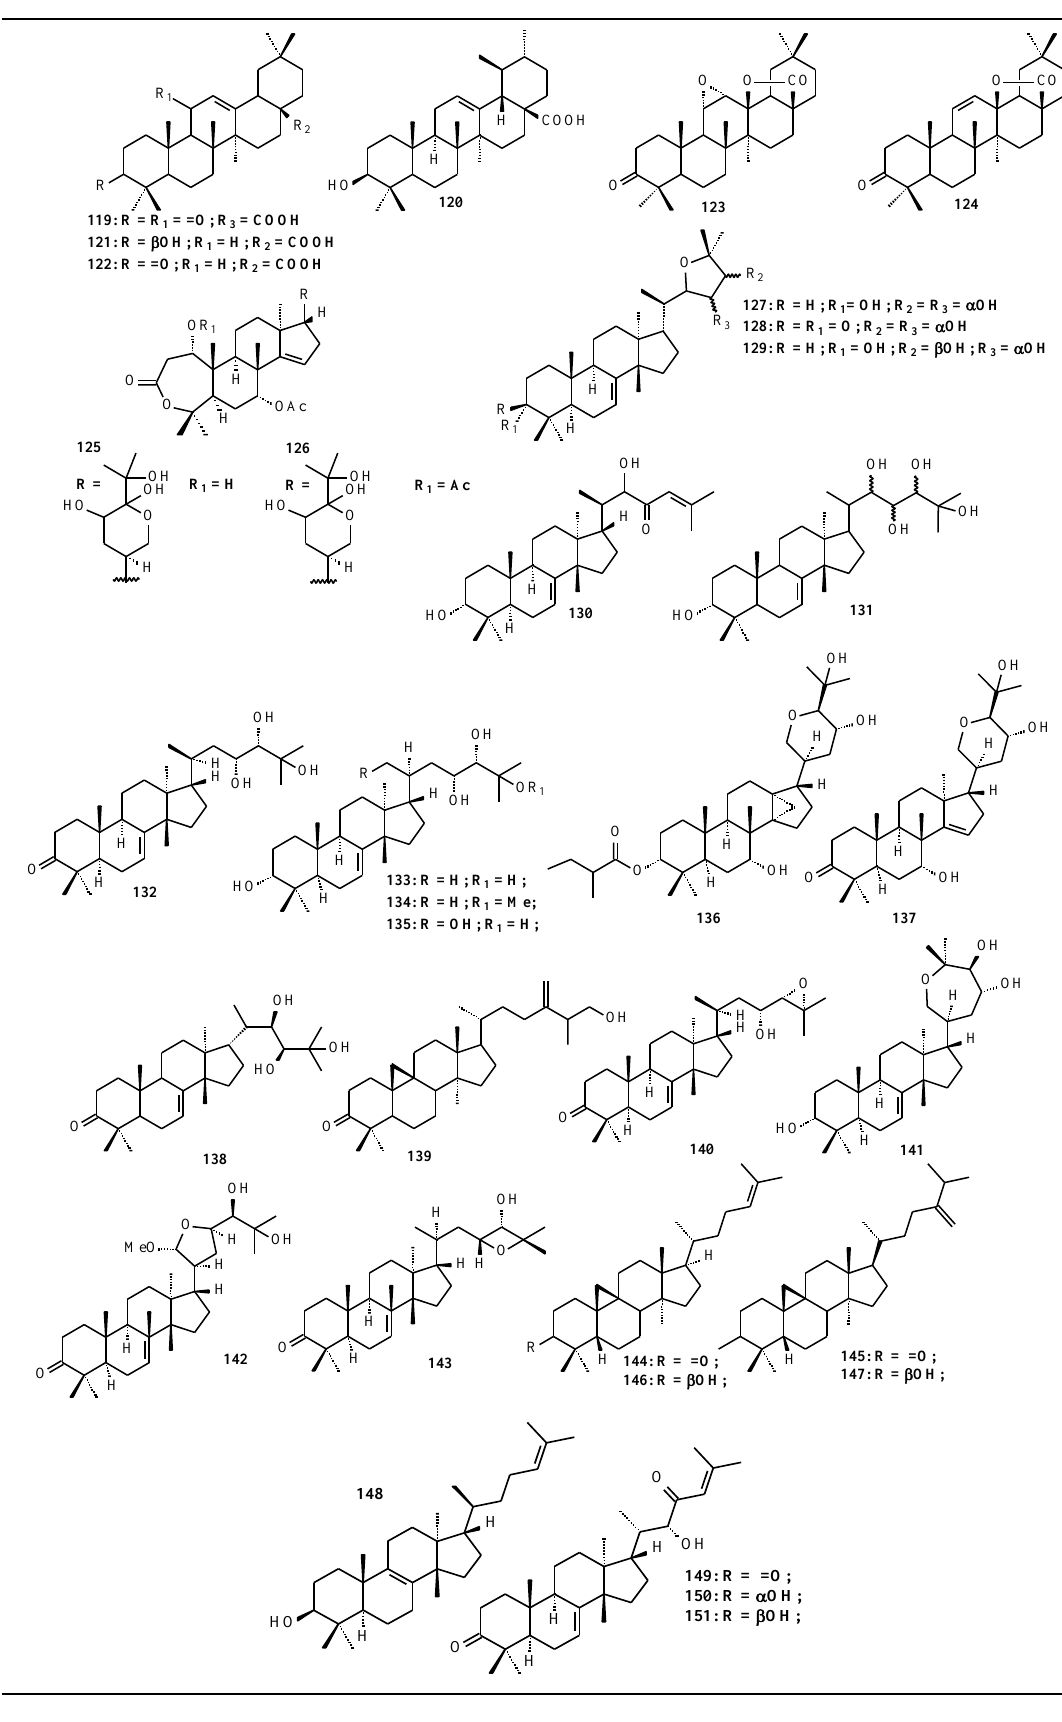
Table 6. Cont. Molecules 2020 , 25 , x FOR PEER